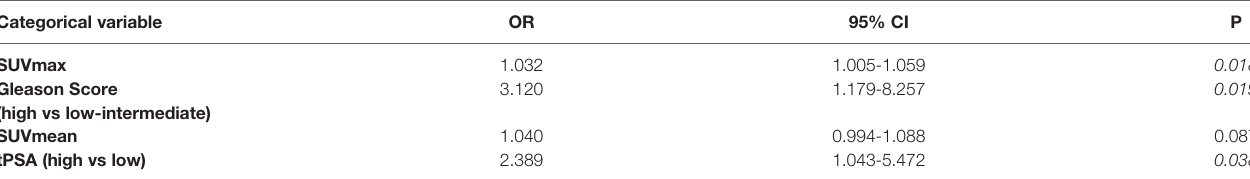
TABLE 3 | Logistic analyses of factors predicting prostate cancer metastasis. Categorical